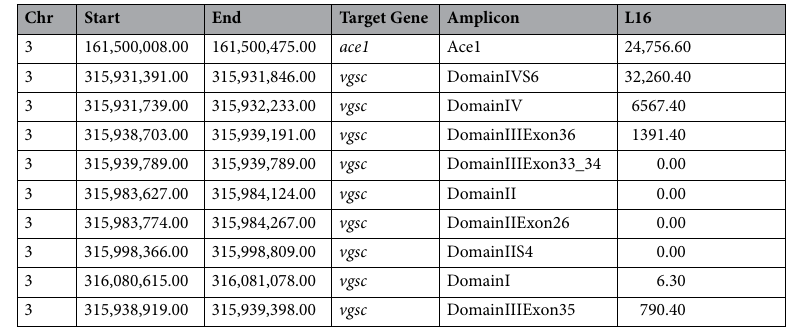
Table 2. Coverage for Ae. aegypti eDNA-L16 insecticide resistance amplicon targets. Chromosome number (chr) start and end of the target amplicon, the target gene, amplicon name and coverage are